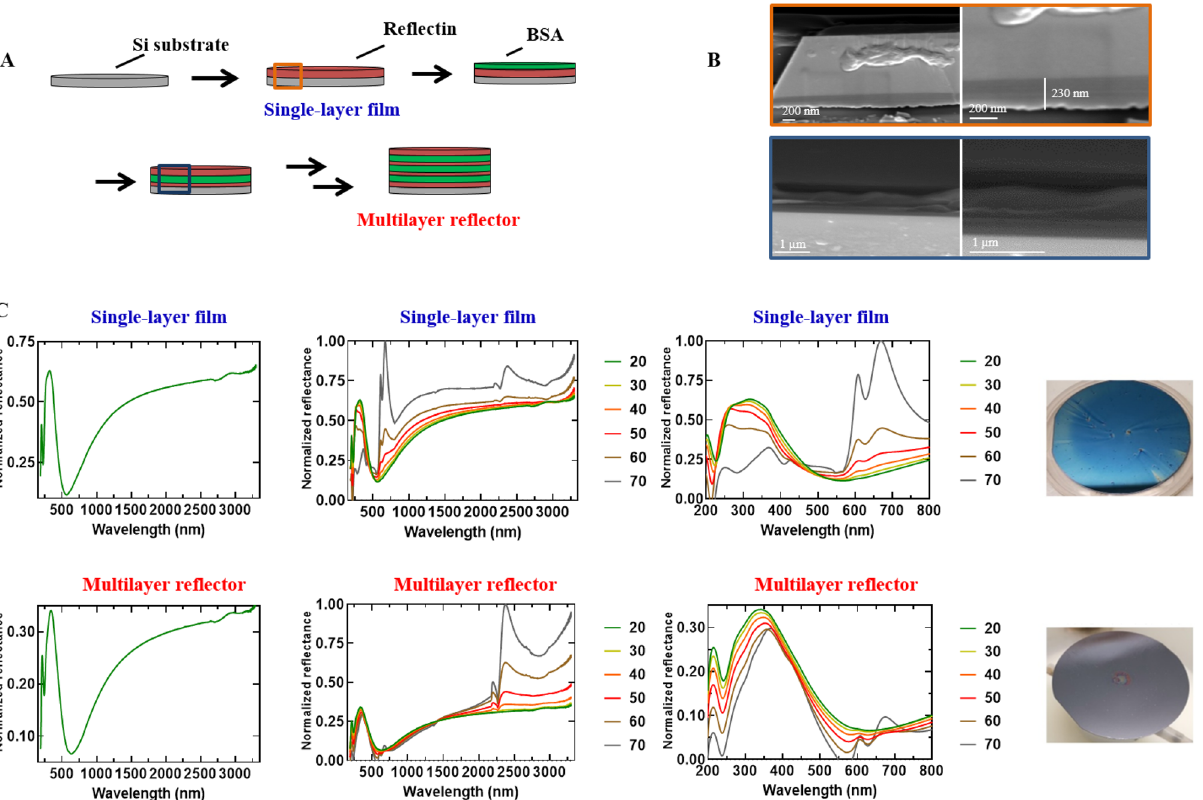
Figure 6. ( A ) Schematic figure showing the fabrication of reflectin single- and multilayer thin-films ( B ). ( C ) UV–Vis–NIR reflectance spectra of reflectin DORefA2 single-layer film (top) and DORefA2 Bragg reflector (bottom) along with the corresponding camera image. Left column; full spectra at 20°, middle column; full spectra at 20°–70°, right column; UV–Vis reflectance spectra at 20°–70°. Right: Optical images of DoRefA2 single-layer film (top) and DoRefA2/BSA multilayer